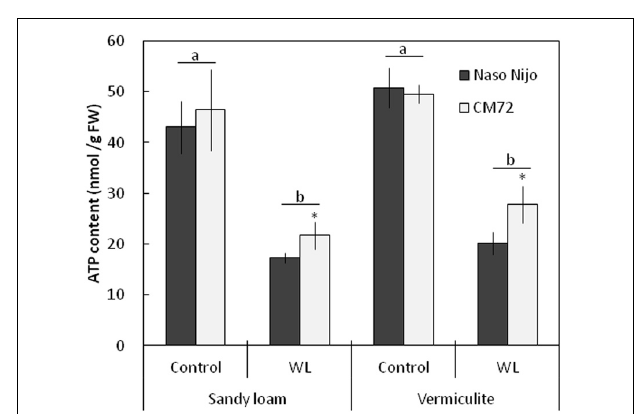
composition, refer to the Materials and Methods section. Mean ± SD ( n = 5). Different lower case letters indicate the significant difference between treatments (averaged for both genotypes) at P < 0 . 01. Asterisks indicate the significant difference between cultivars within treatment at ∗ P < 0 . 01, ∗∗ P < 0 . 001, and ∗∗∗ P < 0 . 0001.